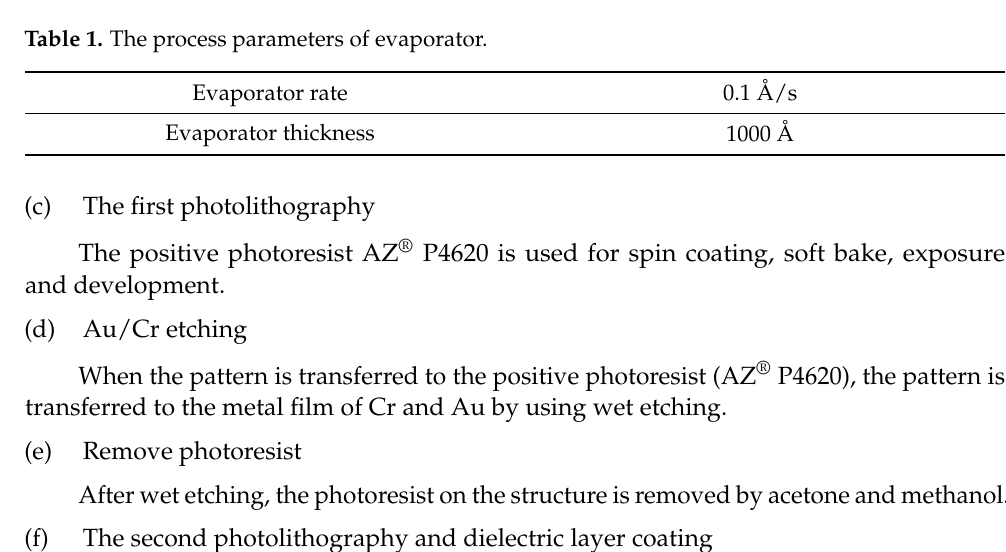
Table 1. The process parameters of evaporator.